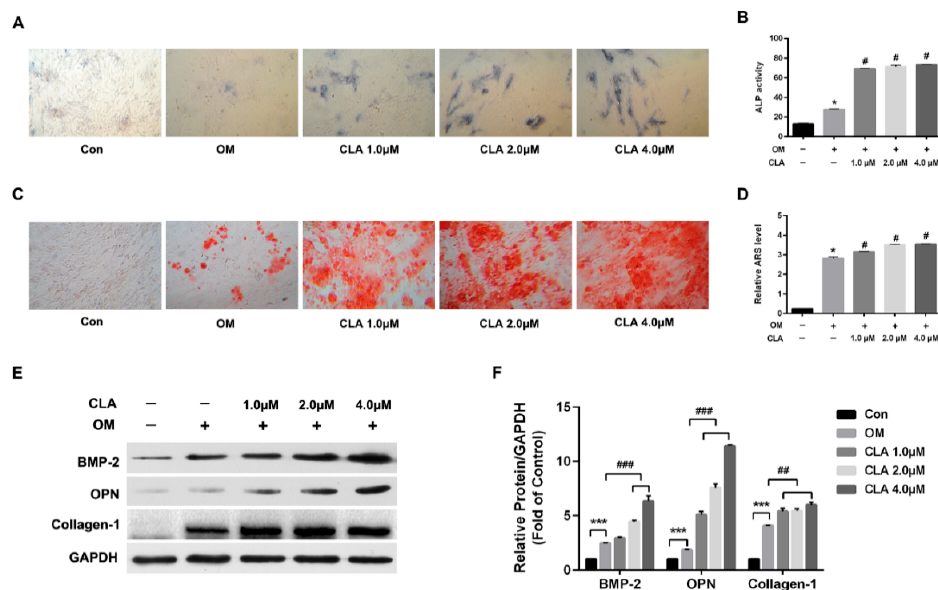
Figure 2. CLA promoted osteoblast differentiation in hBMSCs. hBMSCs (Con) were induced for osteoblast differentiation for 15 d, without (OM) or with different concentrations of CLA (CLA). ( A ) Cellular ALP activity (blue) detected using ALP activity staining kit (100 × ); ( B ) quantitative analysis of ALP activity; ( C ) extracellular calcium deposits (red) detected by alizarin red S (ARS) staining (100 × ); ( D ) quantitative analysis for calcium-combined ARS; ( E ) osteoblast-specific proteins detected by Western blotting; ( F ) protein expression levels normalized to GAPDH. Data are expressed as mean ± SD ( n = 3). Compared to Con, data were significantly different at * p < 0.05 and *** p < 0.001; compared to OM, data were significantly different at # p < 0.05, ## p < 0.01, ### p < 0.001.